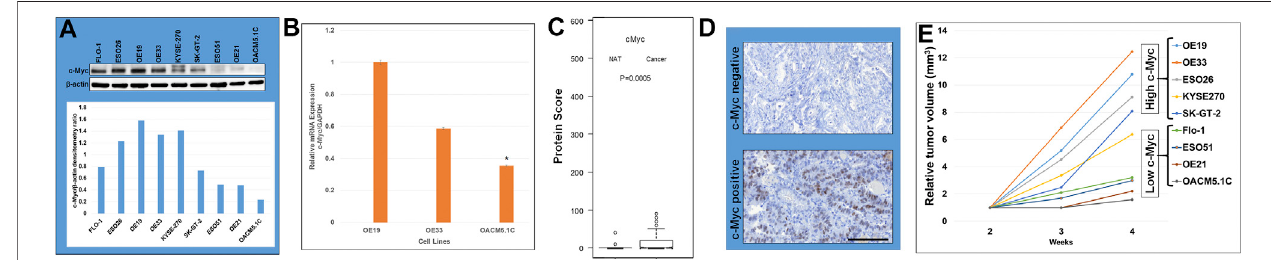
FIGURE 1 | c-Myc overexpression in human esophageal cancer (EC) cell lines and tissues. (A) Western blot analysis showing c-Myc expression in EC cell lines. GAPDH serves as loading control. c-Myc over-expression was frequent in this panel of EC cell lines. Densitometric analysis of Western blot showing c-Myc expression the highest in OE19 and the lowest in OACM5.1C. (B) c-Myc mRNA expression comparable to protein expression. It is high in OE19/OE33 and low in OACM5.1C. (C) There is signi fi cantly ( p < 0.05) higher c-Myc expression in esophageal cancer (Cancer) compared to normal adjacent tissue (NAT) as determined by tissue microarray. (D) Immunohistochemistryshowinghighc-Mycexpressioninc-Mycpositiveesophagealcancercomparedtoc-Mycnegativenormalesophagealtissue. (E) c-Myc overexpression correlated with accelerated esophageal cancer subcutaneous xenograft tumor growth. Five million cells of each cell line were injected subcutaneously in each athymic nude